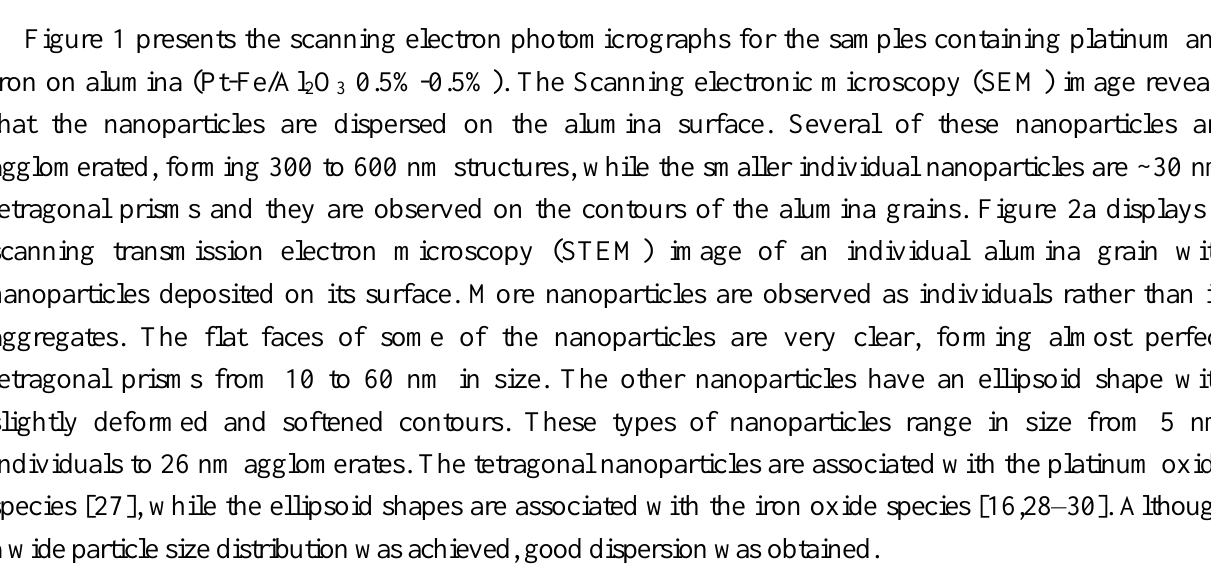
Figure 1. SEM image of Pt-Fe/Al